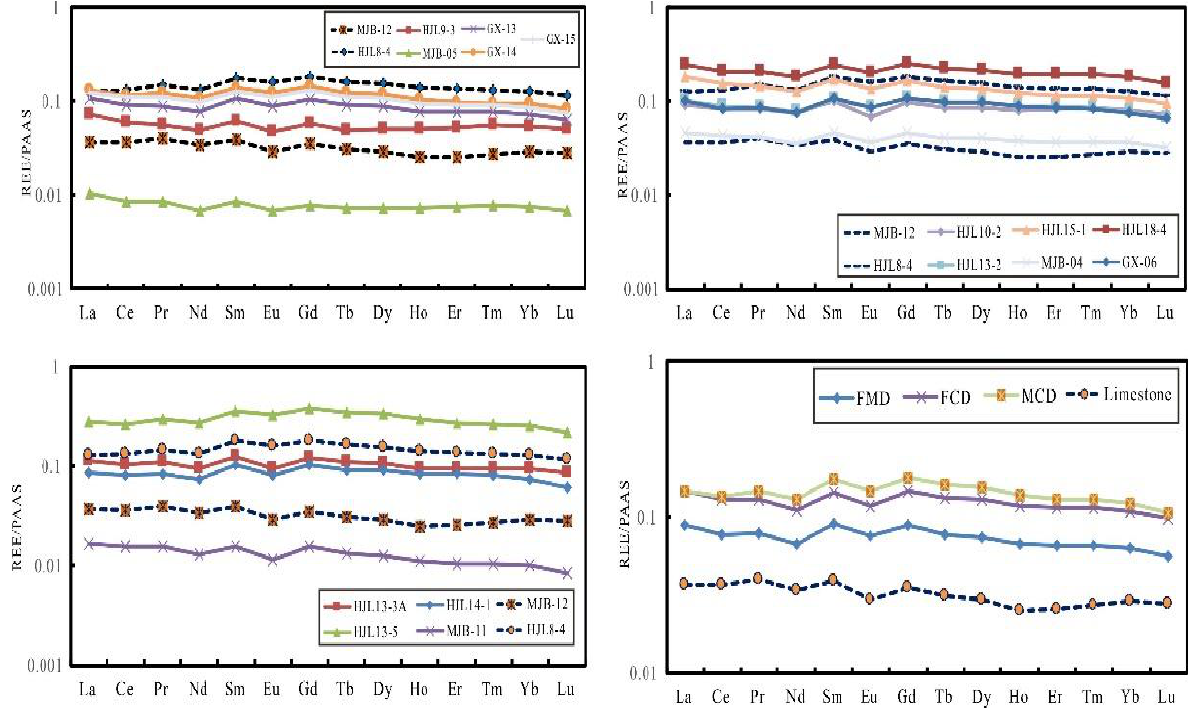
Figure 6. North America Shale Composite-normalized REE assemblage patterns of the Devonian Guanwushan Formation (D 2 g) dolomites in the northwestern Sichuan Basin.